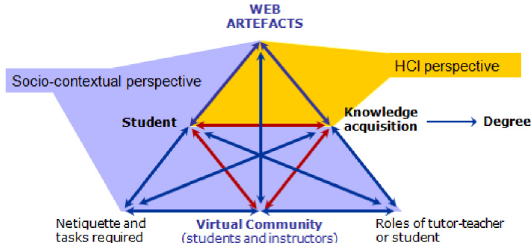
Figure 2. An example of an activity system of a virtual university course. Highlighted are the areas of investigation of HCI cognitive perspective and of the activity theory approach (adapted from